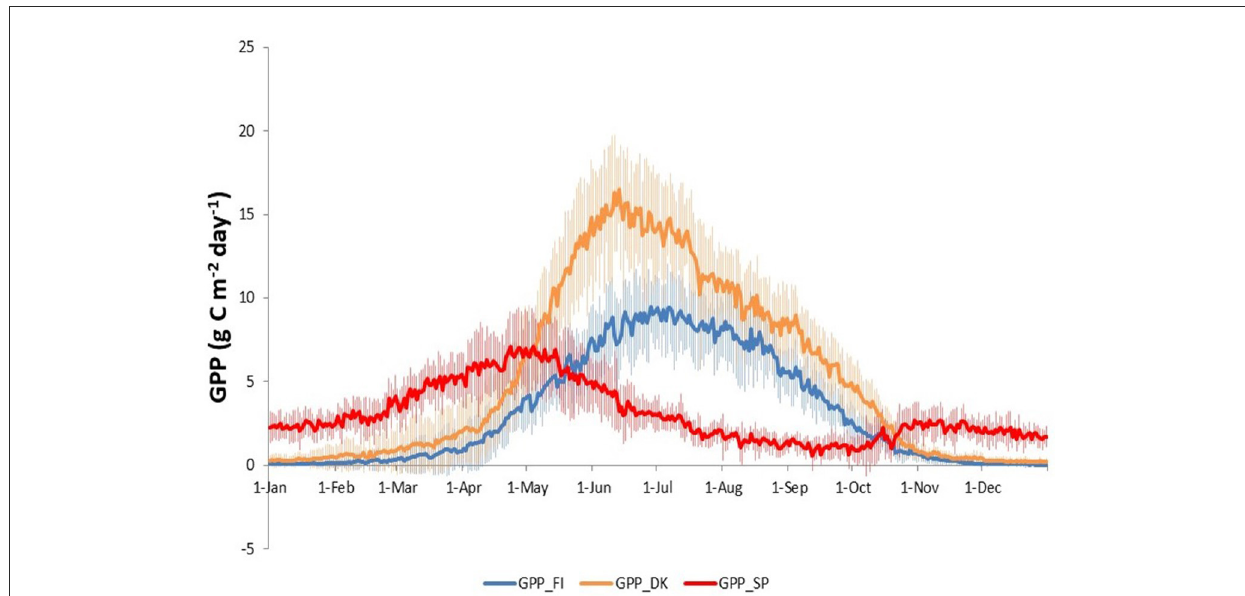
FIGURE2 Annual average, i.e., Buys-Ballot, of daily GPP time series in three European ecosystems: Evergreen Needleleaf Forest of Finland (ENF_FI, blue line), Deciduous Broadleaf Forest of Denmark (DBF_DK, orange line) and Mediterranean Savanna ecosystem of Spain (SAV_SP, red